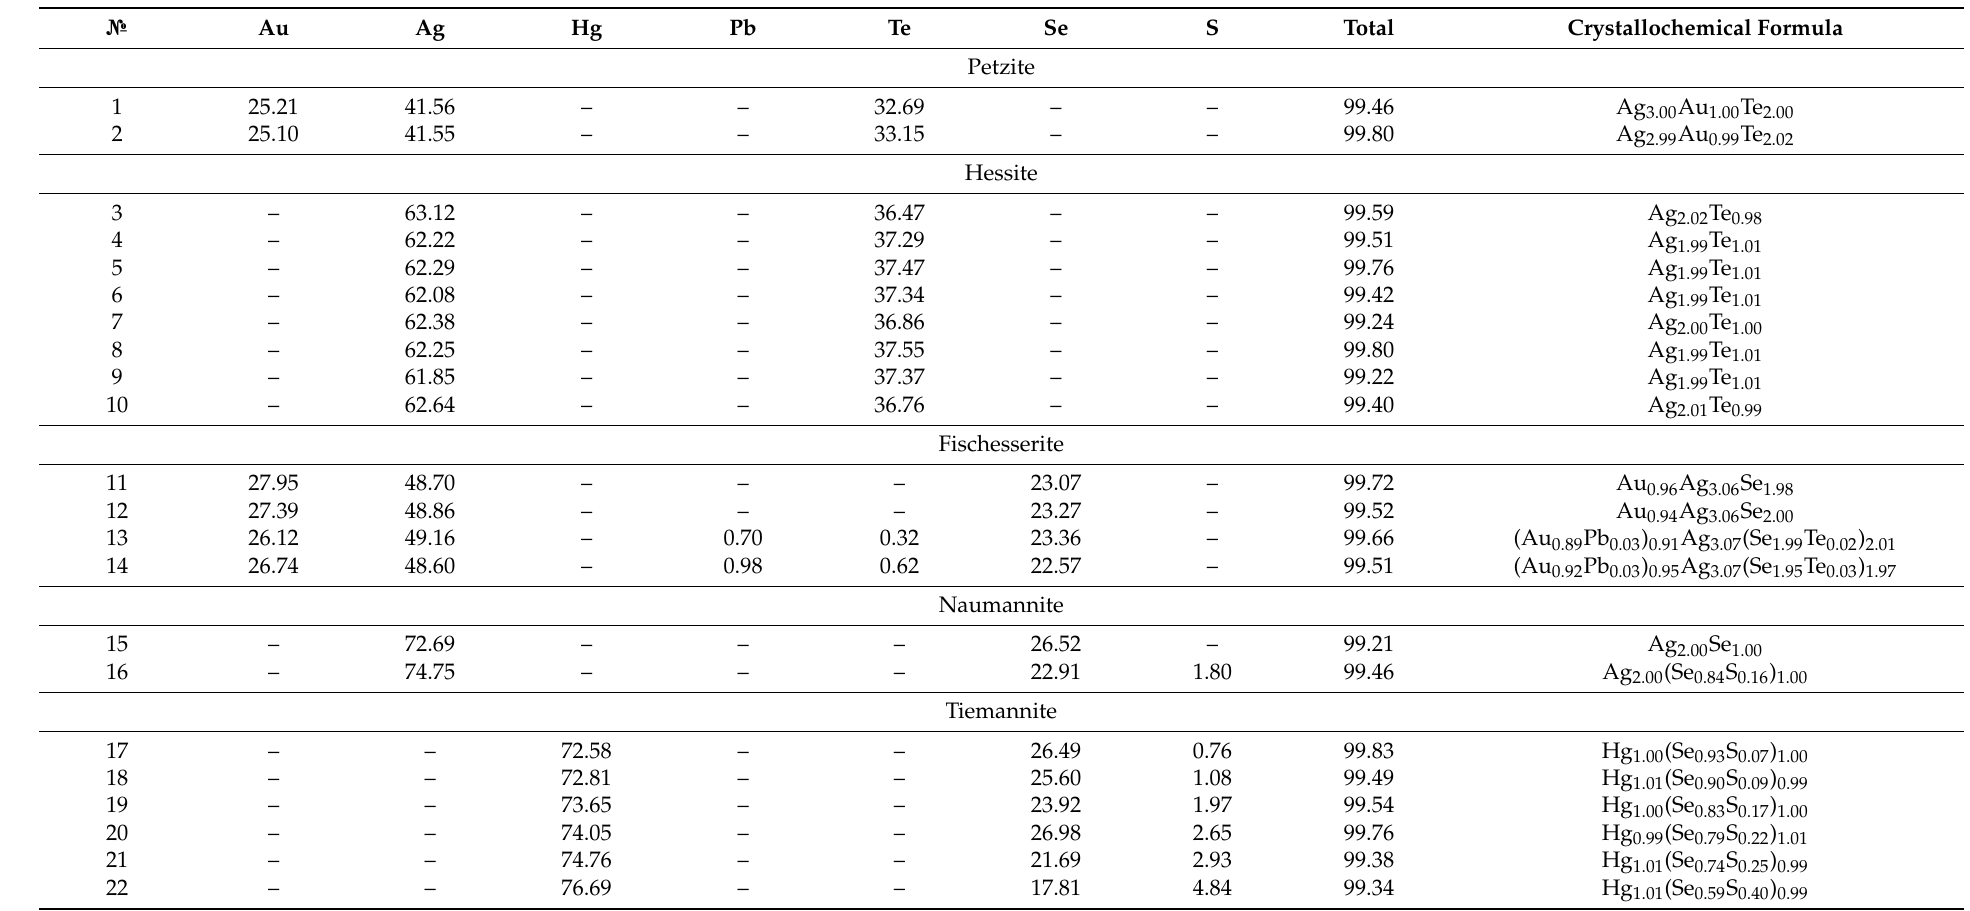
Table 1. Chemical composition of petzite, hessite, fischesserite, naumannite, and tiemannite, wt